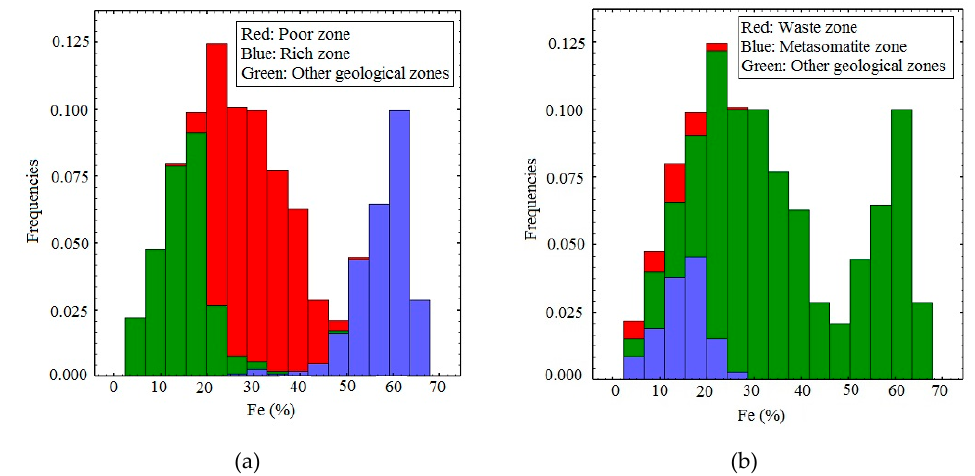
Figure 4. The proportions of the grades data in different geologic domains. ( a ) shows the overlapping of poor, rich and other geological zones, ( b ) shows the overlapping for waste, metasomatite and other geological